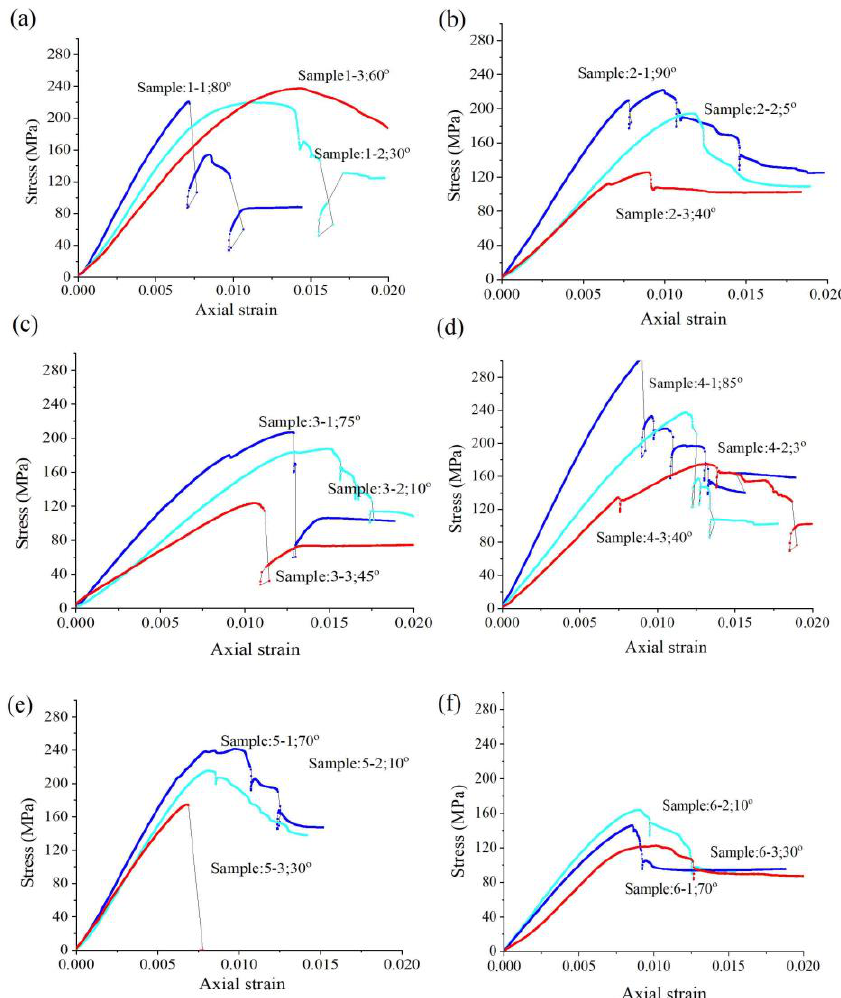
Figure 4. Stress–strain curves of the six laminated core samples with different lamina angles at a 20 MPa confining pressure. ( a ) Core-1; ( b ) Core-2; ( c ) Core-3; ( d ) Core-4; ( e ) Core-5; ( f ) Core-6. Blue lines indicate those samples in a high lamina angle range, cyan lines indicate those samples in a low lamina angle range, and red lines indicate those samples in a medium lamina angle range.